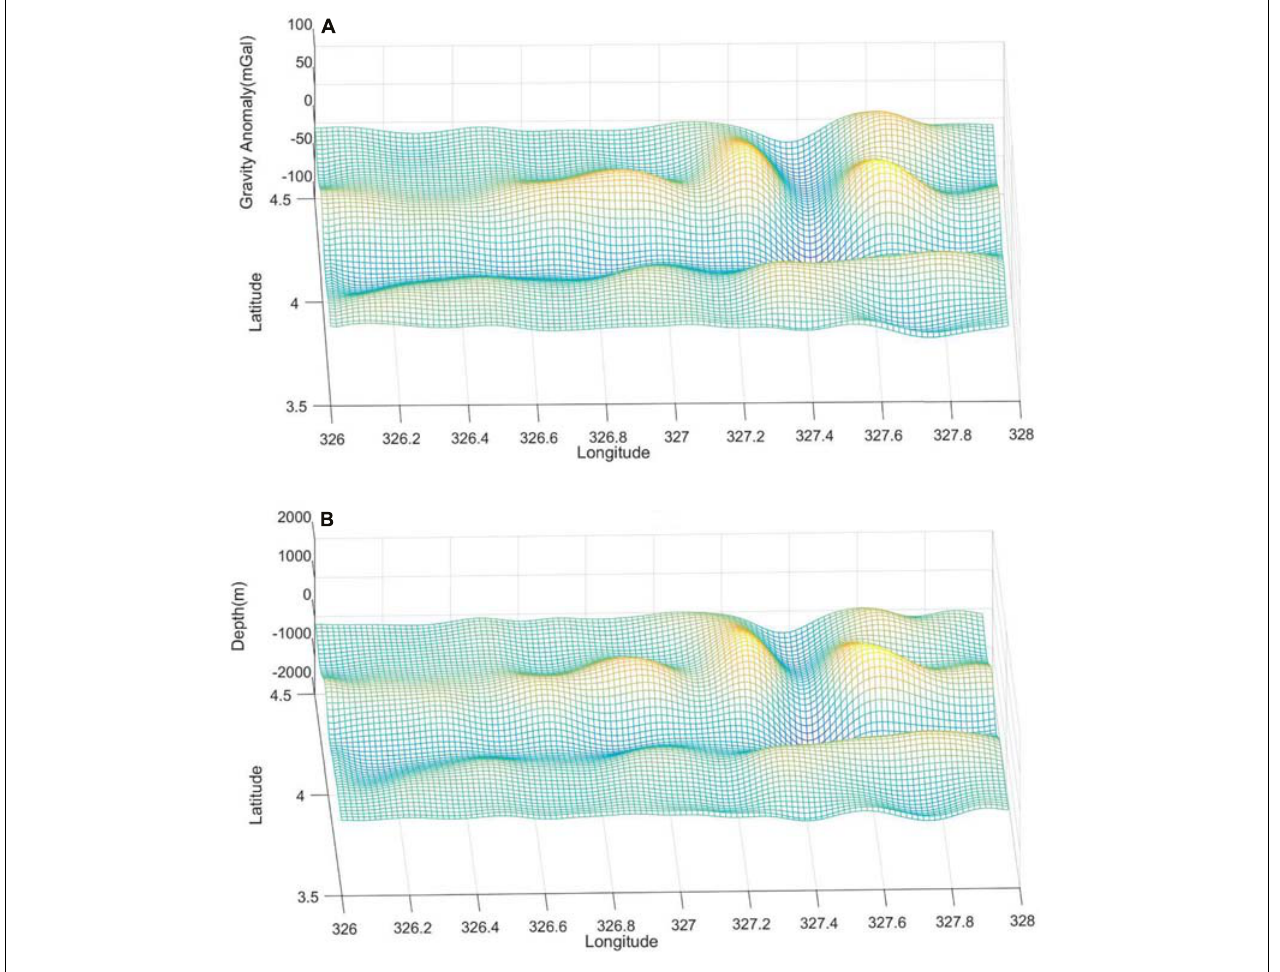
FIGURE 5 | The filtered gravity anomaly (A) and shipborne depths (B) .